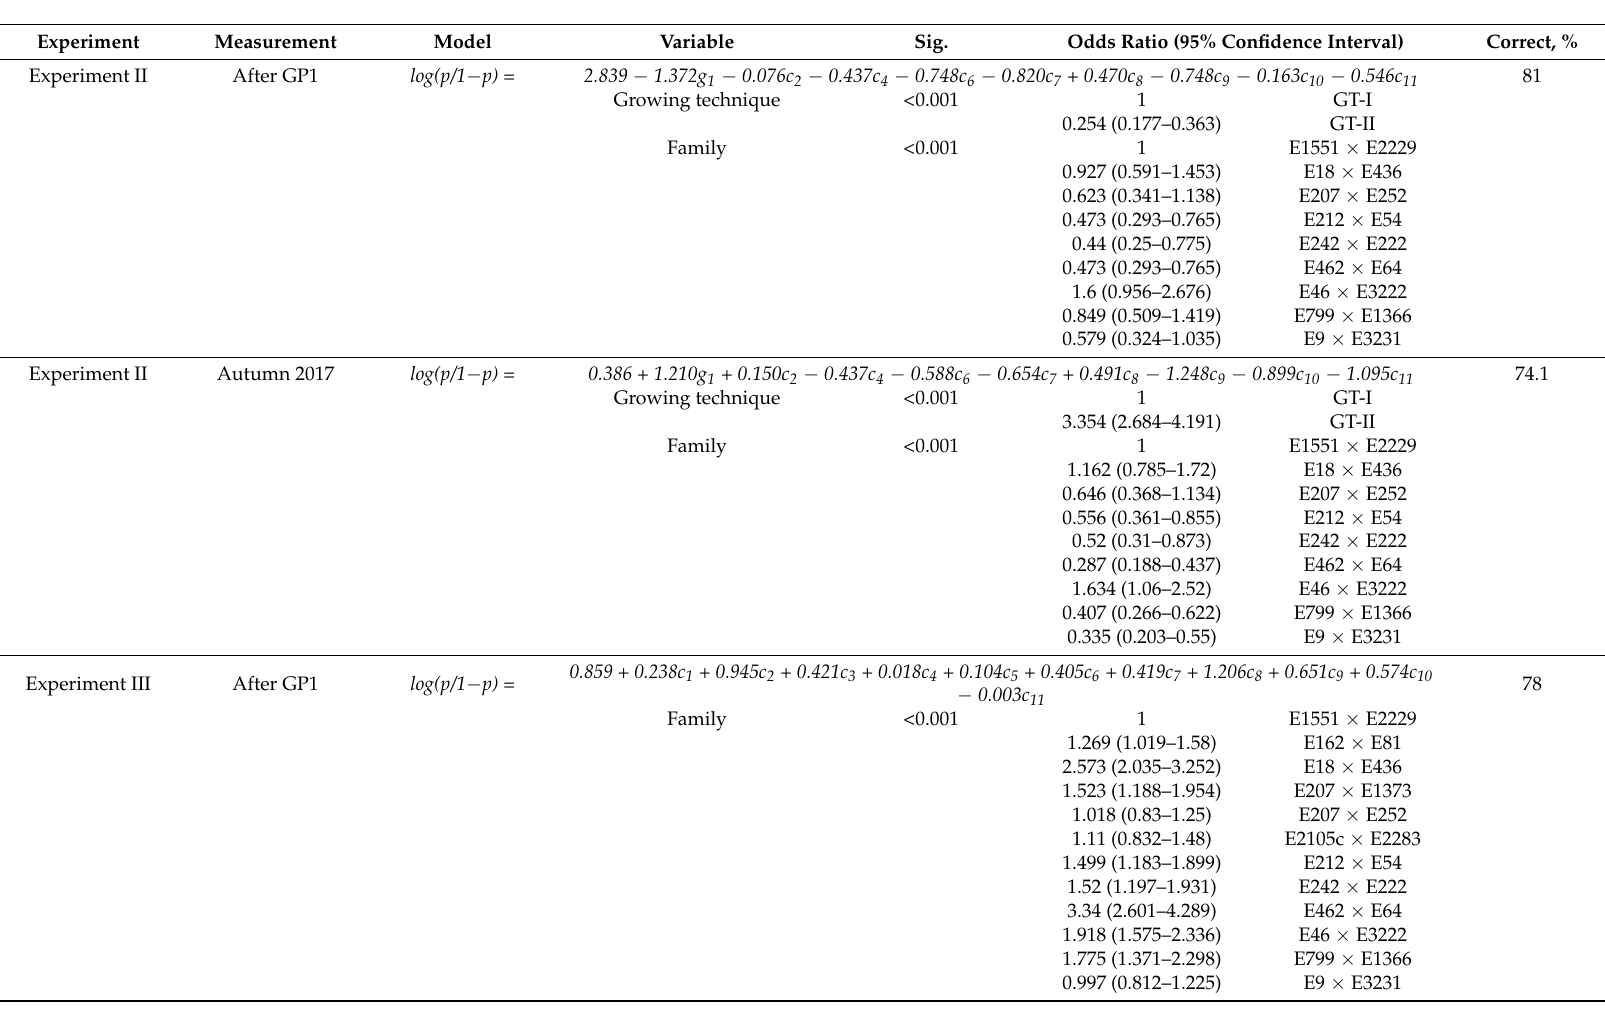
Table 3. Logistic regression models used for analyzing binary response (living or dead) in different growing techniques (GT-I and GT-II), after first growing season in the nursery or artificial growing season in growth room (GP1) and after the growing season of 2017 in the nursery, for Experiments II and